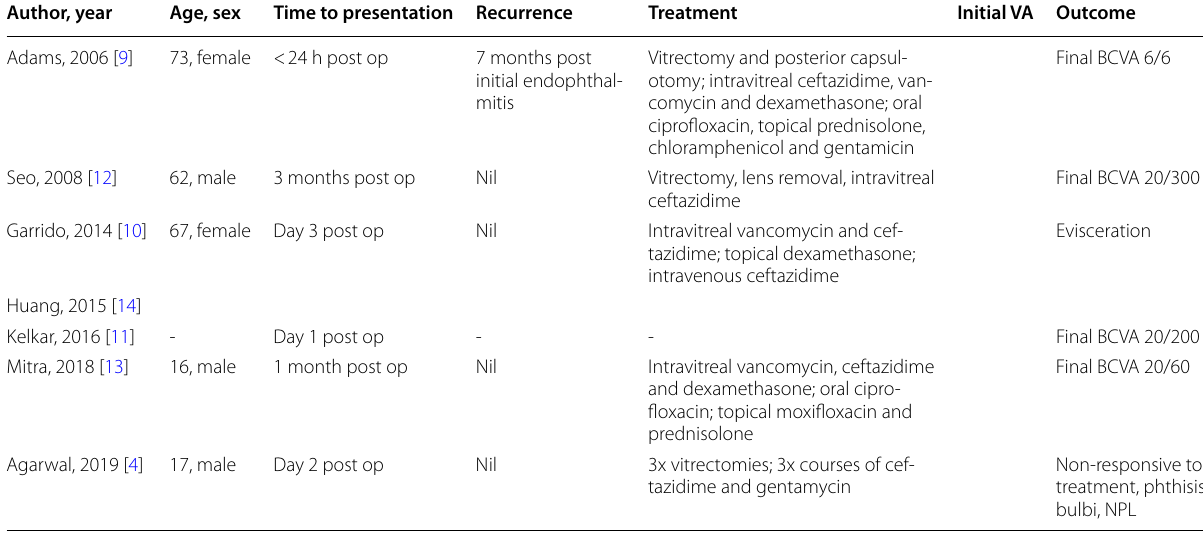
Table 1 Cases of postoperative endophthalmitis caused by Sphingomonas paucimobilis Author,